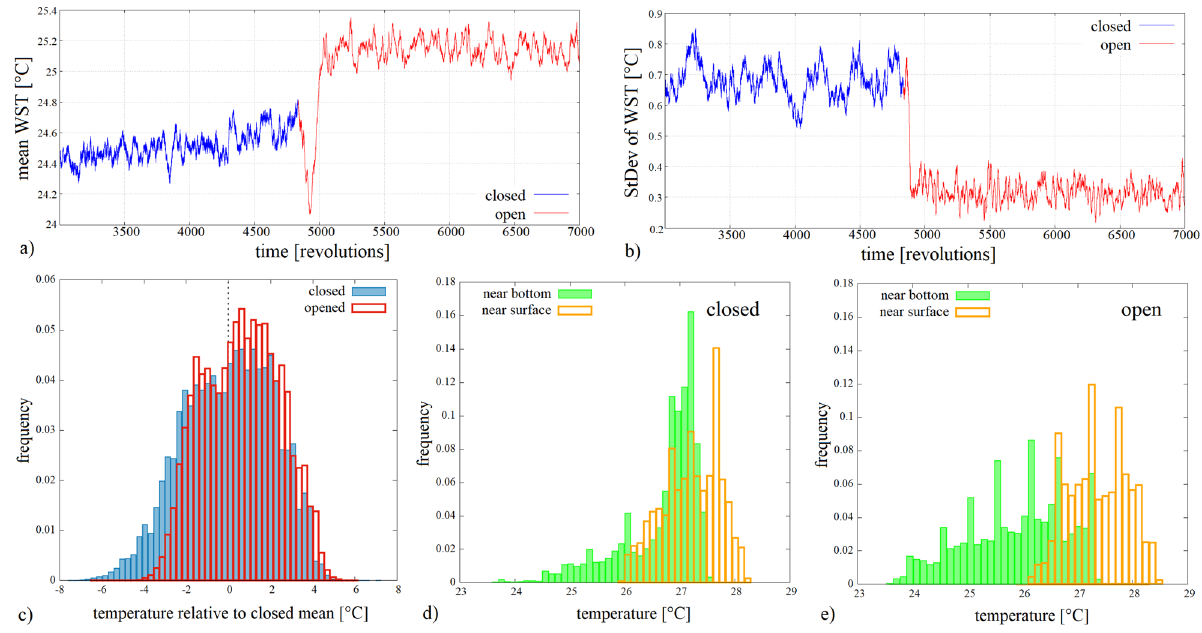
Figure 3. Water surface temperature (WST) distributions before and after the opening. ( a ) The time series of the spatially averaged WST field at each time instant, following a 10-revolution running averaging for smoothing. The change of color (from blue to red) marks the removal of the barrier ( (cid:31) = 2.0 rad/s, (cid:31) T r = 18.7 ◦ C). ( b ) The spatio-temporal standard deviation of the fluctuations of the WST field, as calculated with a 10-revolution moving window in the same experiment as in panel ( a ). ( c ) Histograms of the WST field of the entire surface acquired from the data of ∼ 1700 revolutions in both the “closed” (blue) and “open” (red) legs of the same experiment as of panels ( a ) and ( b ). ( d , e ), Histograms of temperature time series obtained at the same horizontal location via co-rotating temperature sensors placed underneath each other, one close to the surface, at a depth of 6 mm and the other above the bottom by 5 mm from a control experiment (with a total water height of H = 5 cm). The near-surface histograms are shown with orange and the near-bottom ones are green. Panel ( d ) represents the “closed” and panel ( e ) the “open” leg of the same experiment ( (cid:31) = 2.0 rad/s, (cid:31) T r = 11 ◦ C). The figure was created using Gnuplot version 5.2, Release 5.2.8 (freely available and downloadable at http:// www. gnupl ot.